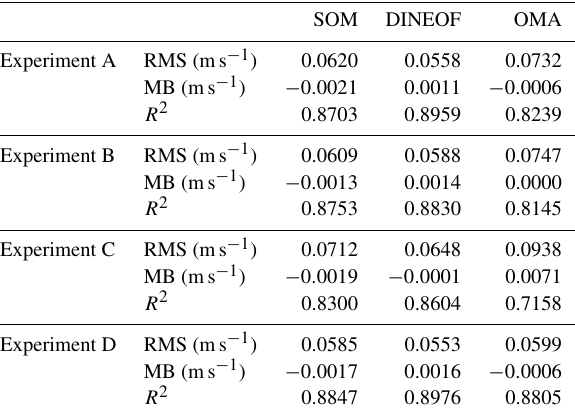
Table 1. Root mean square (RMS) error , mean bias (MB) and cor- relation coefficient ( R 2 ) of the zonal velocities ( u ) obtained using reconstructed HFR field from the three methodologies and for the four experiments with respect to the zonal velocities derived from the reference HFR currents.